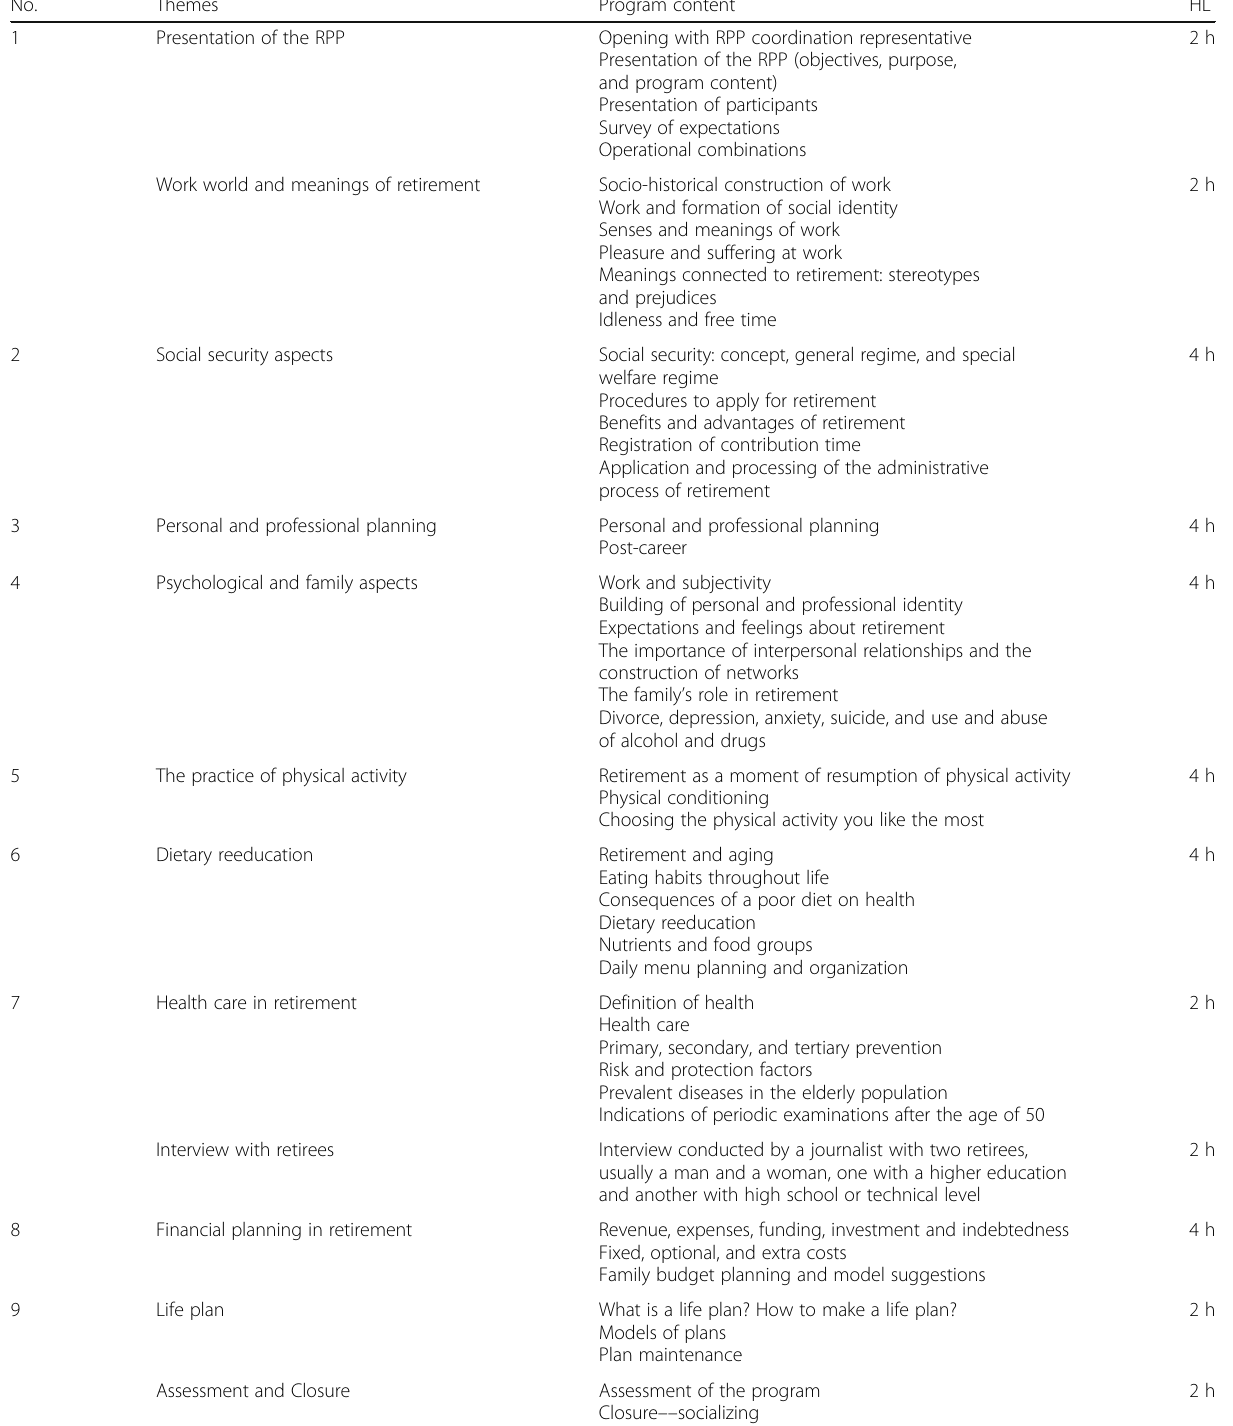
Table 1 Content of the